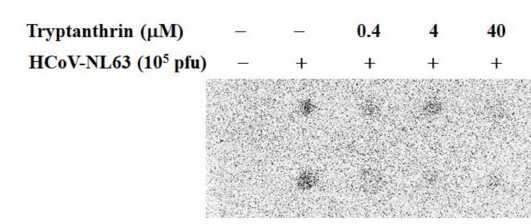
Figure 11. Dot-blotting assay of the HCoV-NL63 / tryptanthrin mixture incubated at 37 ◦ C for 1 h. Tryptanthrin at indicated concentrations was mixed with HCoV-NL63 (10 5 pfu), and then incubated at 37 ◦ C for 1 h. Fifteen microliters of the compound / virus mixture was added onto the nitrocellulose membrane. The nitrocellulose membrane was blocked with 5% skim milk in Tris-Bu ff ered Saline plus 0.1% Tween-20 (TBST) for 2 h, incubated with anti-HCoV-NL63 antibodies overnight, and then reacted with HRP-conjugated anti-mouse IgG antibodies. After washing with TBST, immunoreactive spots of HCoV-NL63 were developed with ECLTM Western Blotting Detection Reagents, and then imaged by the Multi-function Gel Image System. + , add; − , not